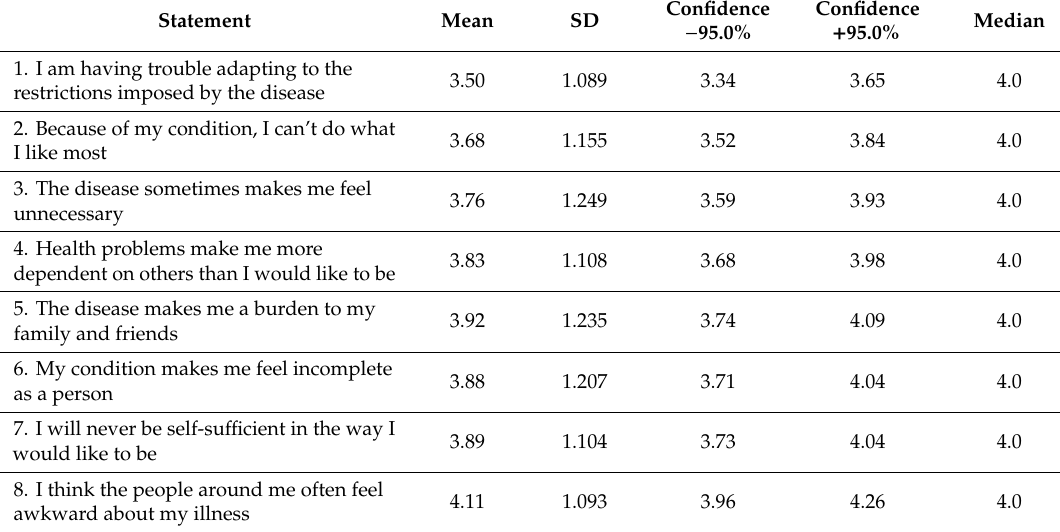
Table 3. Scores for acceptance of illness scale (AIS)